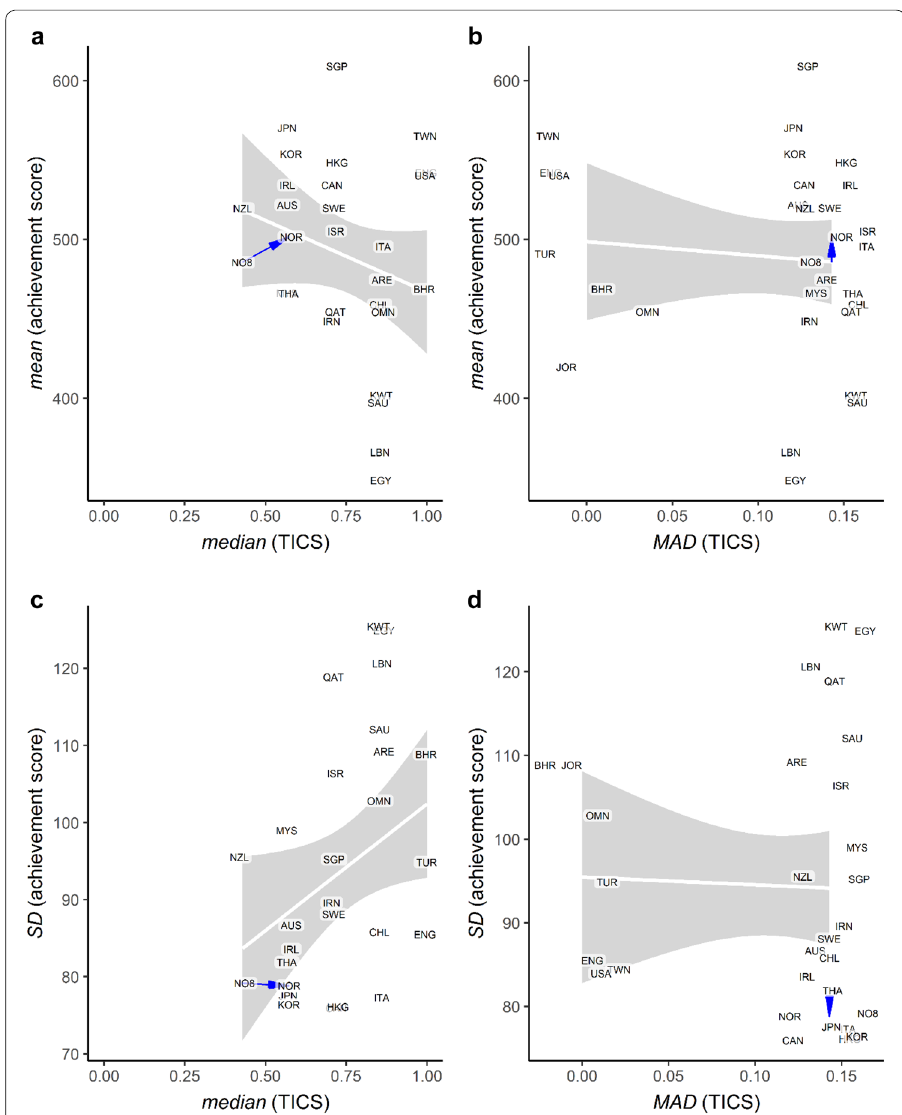
Fig. 6 a – d Scatterplots of between-country relationships in biology between central tendency (mean achievement and median TICS) and spread (standard deviation of achievement and median absolute deviation of TICS). The white line is the best simple linear fit line, and the gray band is its 95% confidence interval (bootstrapped from 10,000 draws). As there was little between-country variation in median absolute deviation (MAD) of TICS, the x -axis values in b and d were slightly jittered to increase visibility of points. The blue arrow indicates the shift from Norway grade 8 to grade